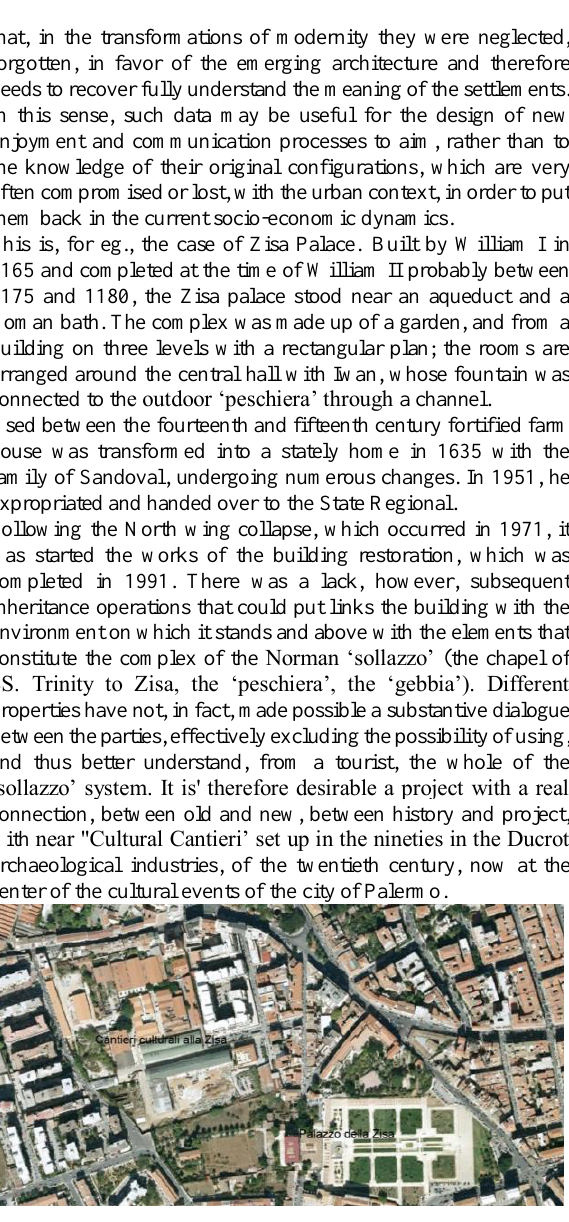
Figure 12. Aerial view fo the Zisa site.